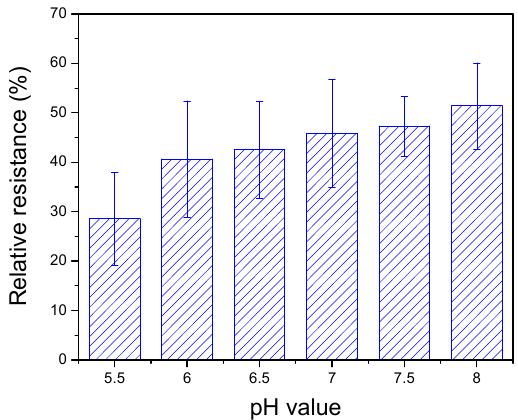
Figure 6. Effect of pH value on the performance of the biosensor with 10 nM Ag(I) concentration at V G = 0 V.